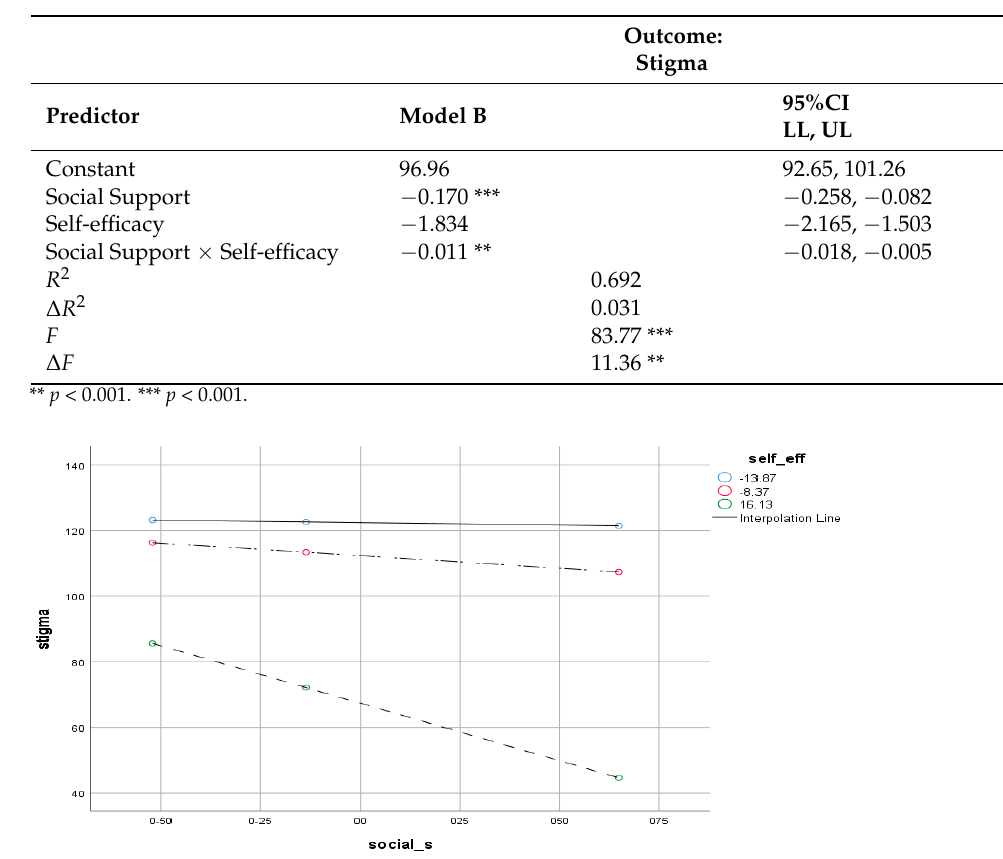
Figure 1. Mod Graph Showing the Interaction Effect of Social Support and Self-Efficacy.